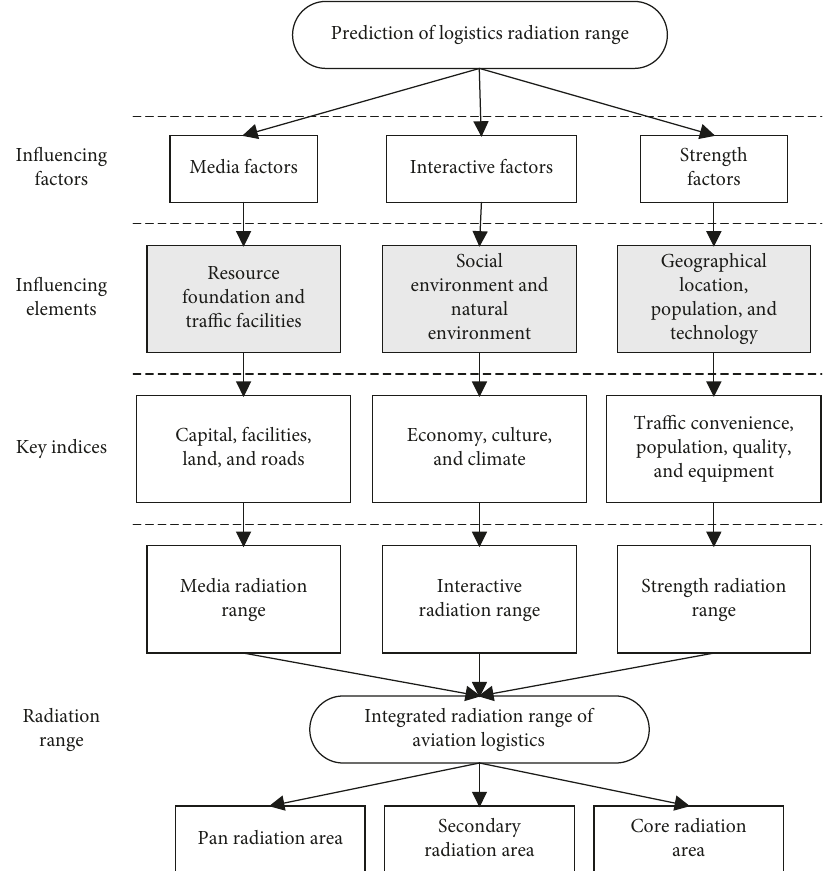
Figure 3: Principle of measuring the integrated logistics radiation range of city